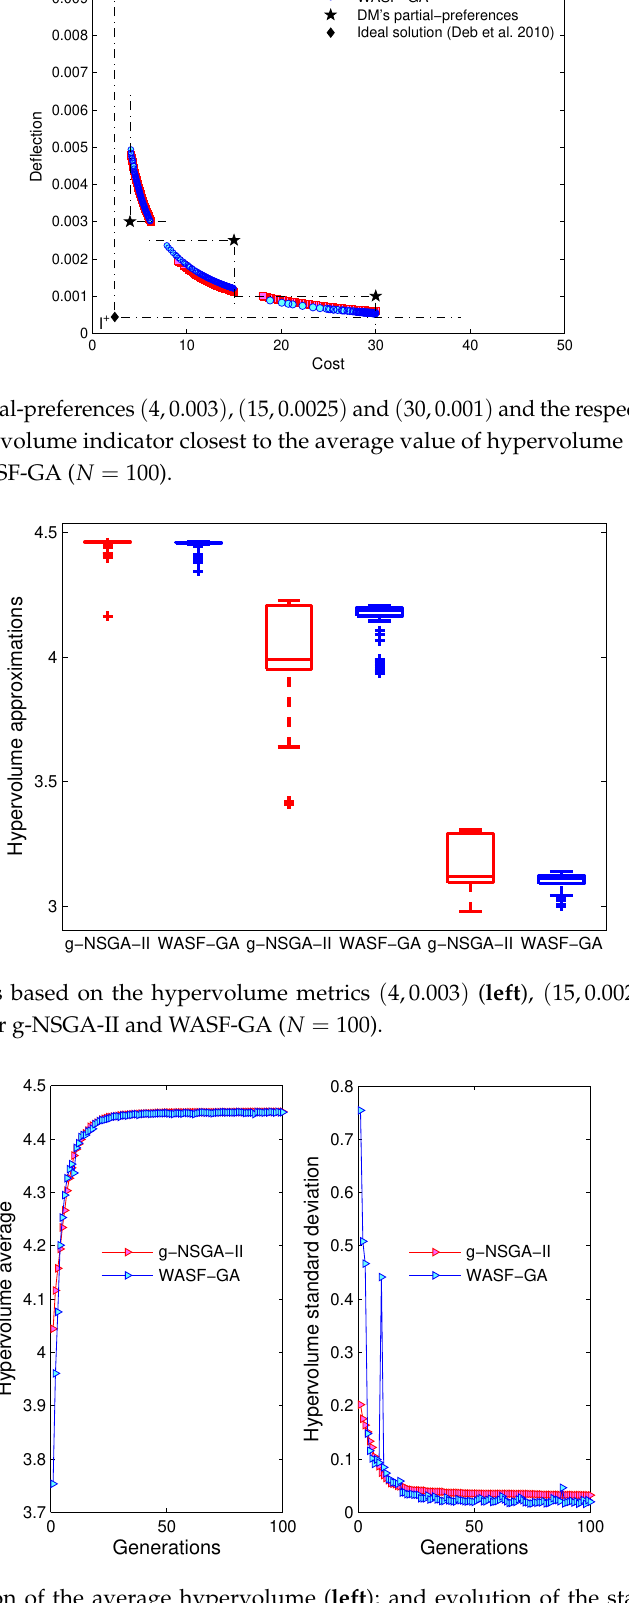
Figure 10. Evolution of the average hypervolume ( left ); and evolution of the standard deviation hypervolume ( right ) for g-NSGA-II, WASF-GA, DM’s partial-preferences ( 4,0.003 ) ( N =